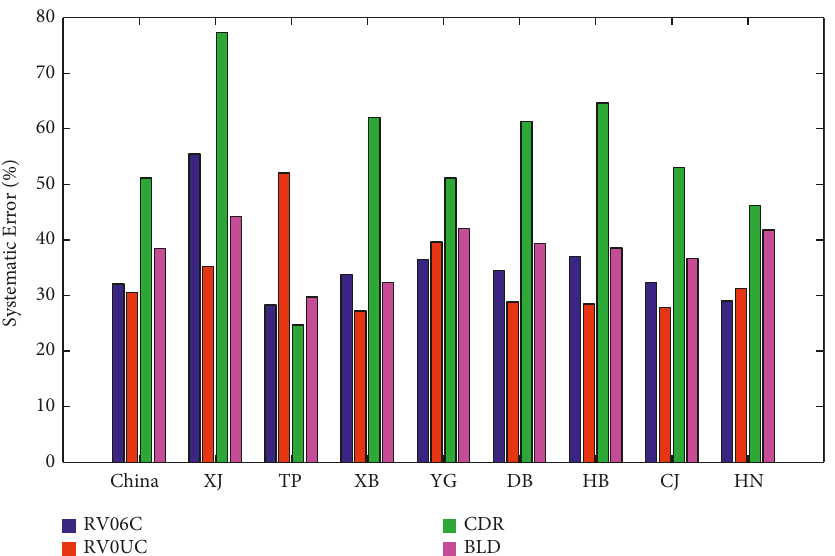
Figure 24: The proportion of systematic errors for the four satellite-based products’ daily precipitation over Mainland China and the eight subregions during the period from March 2014 to June